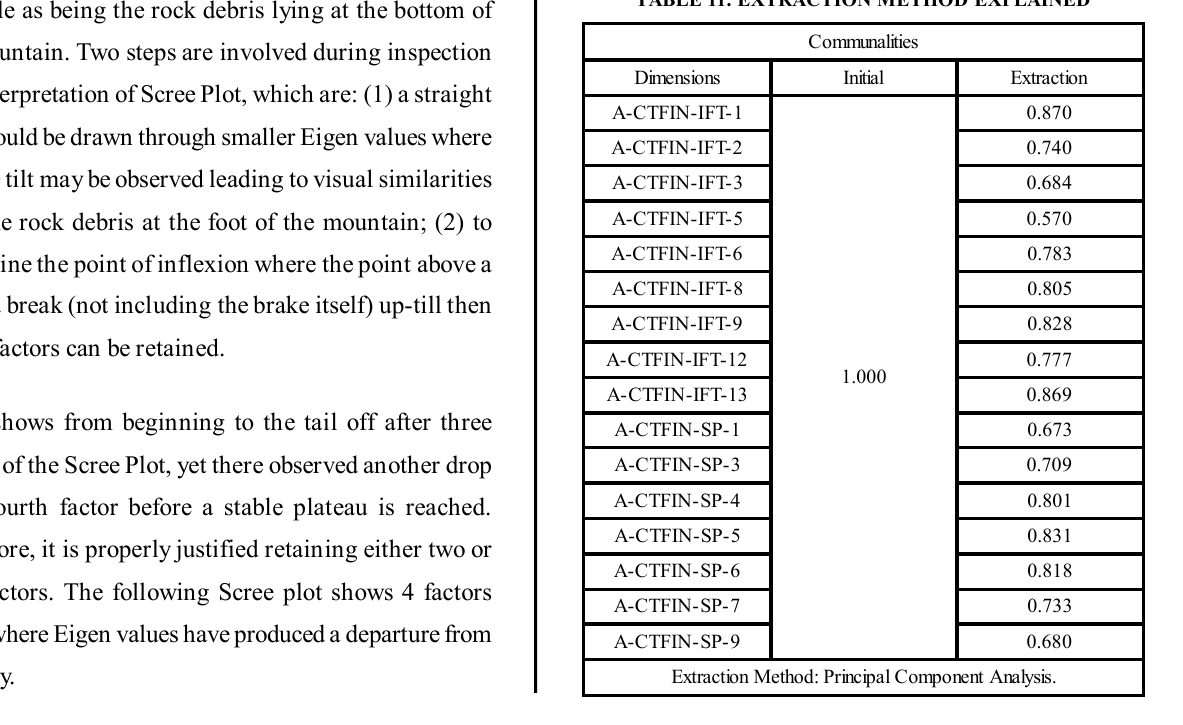
Initial Eigenvalues Extraction Sums of Squared Loadings Componen